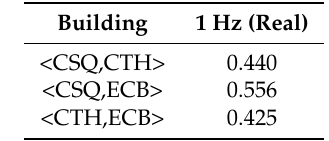
Table 6. Average ρ max for the non-coexistent 1 Hz sampled